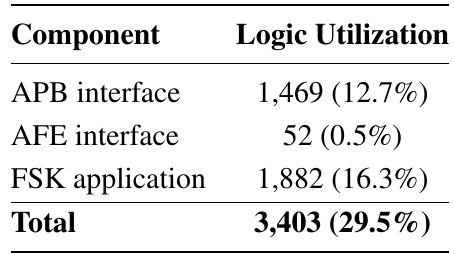
Table 1. FPGA logic resource